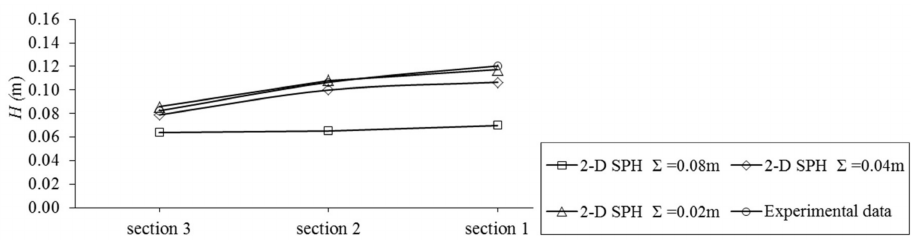
Figure 4. Effect of the initial particle resolution Σ on the numerical simulation.